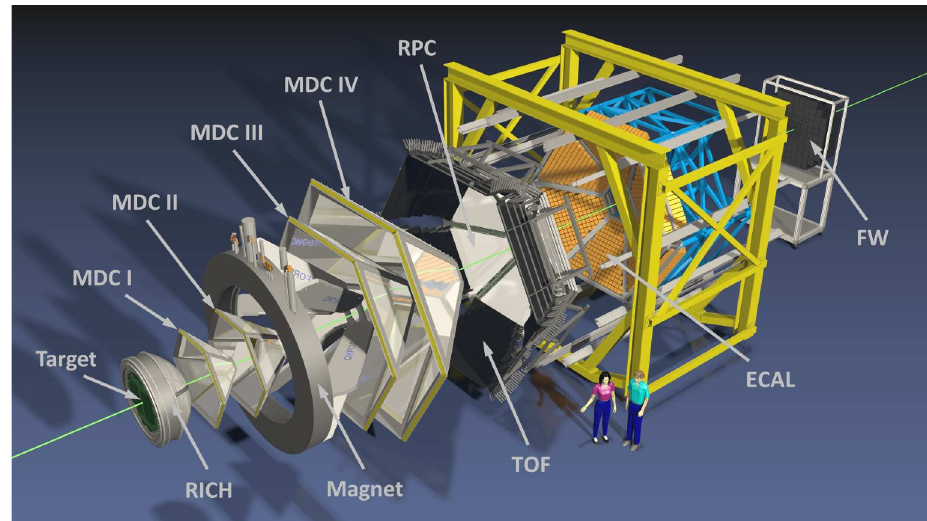
Figure 1. Schematic expanded view of the HADES detector